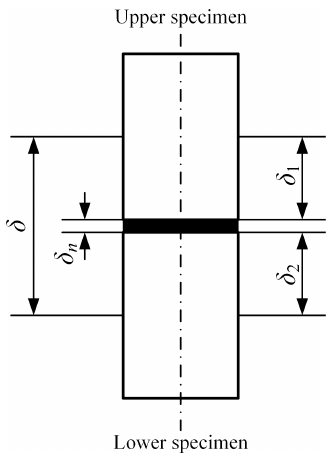
Figure 12. Schematic diagram of deformation between experimen- tal